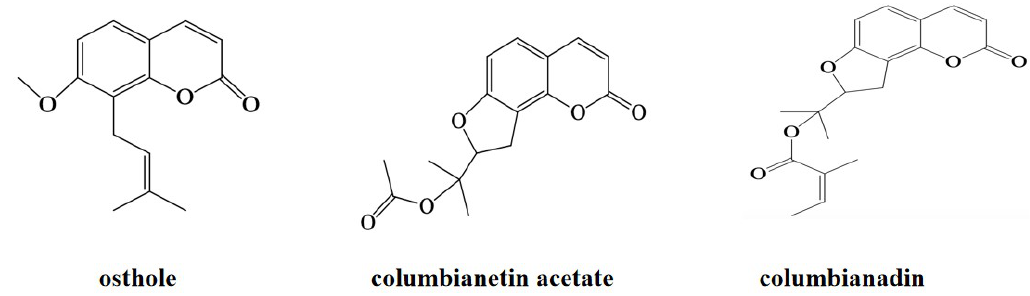
Figure 1. Chemical Structures of three coumarins.